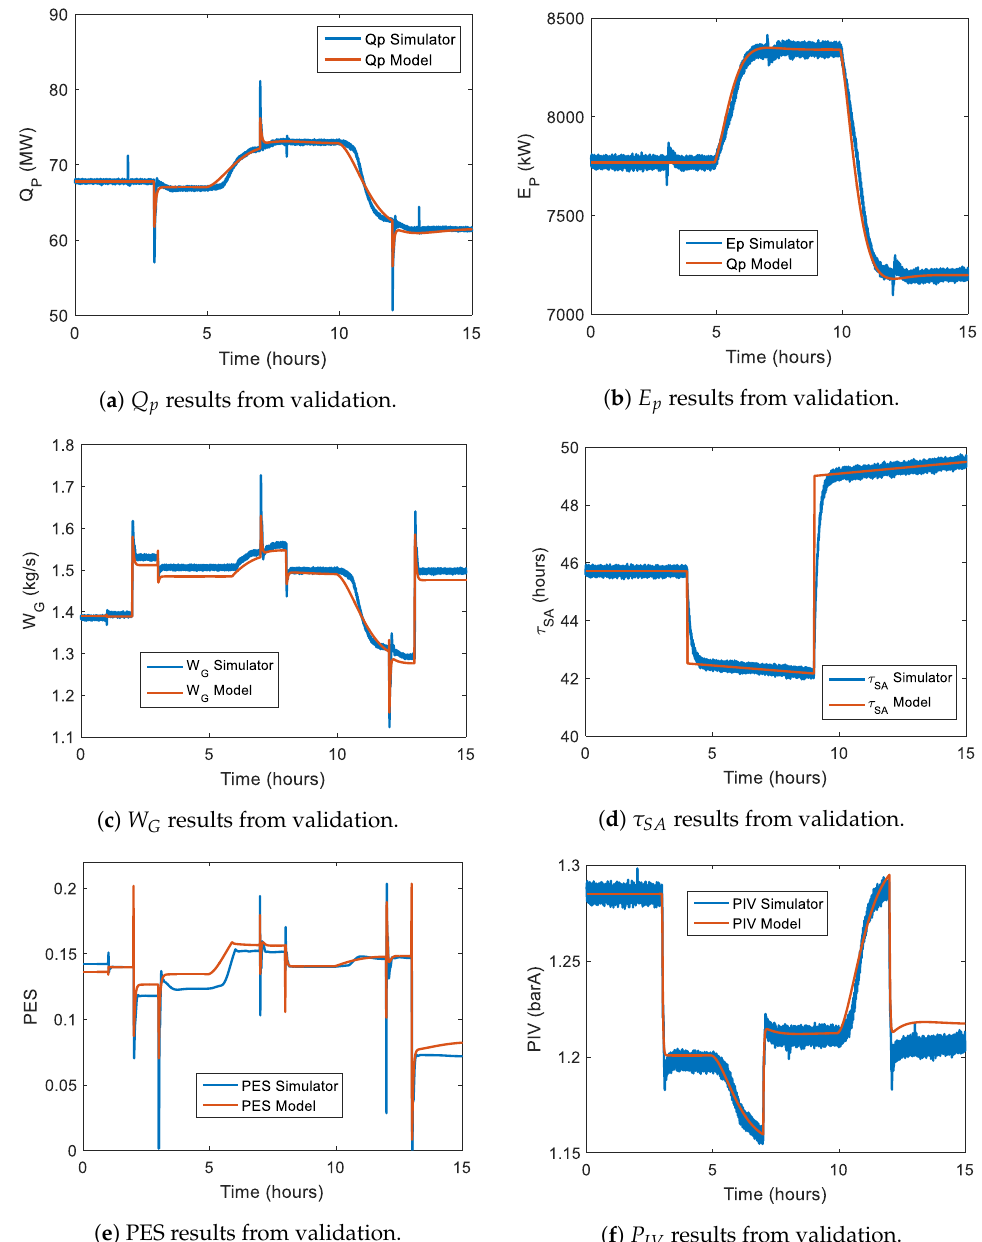
Figure 11. Outputs from data